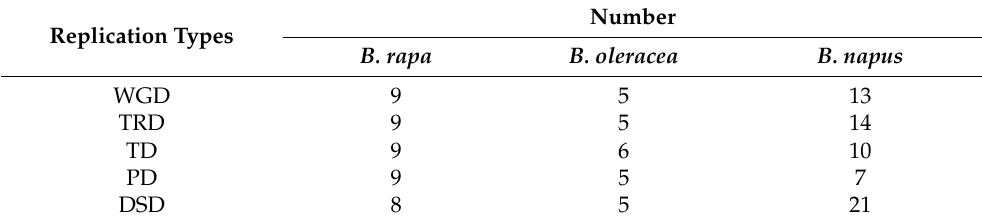
Table 1. Replication types of RCI2 genes in B. napus and its diploid